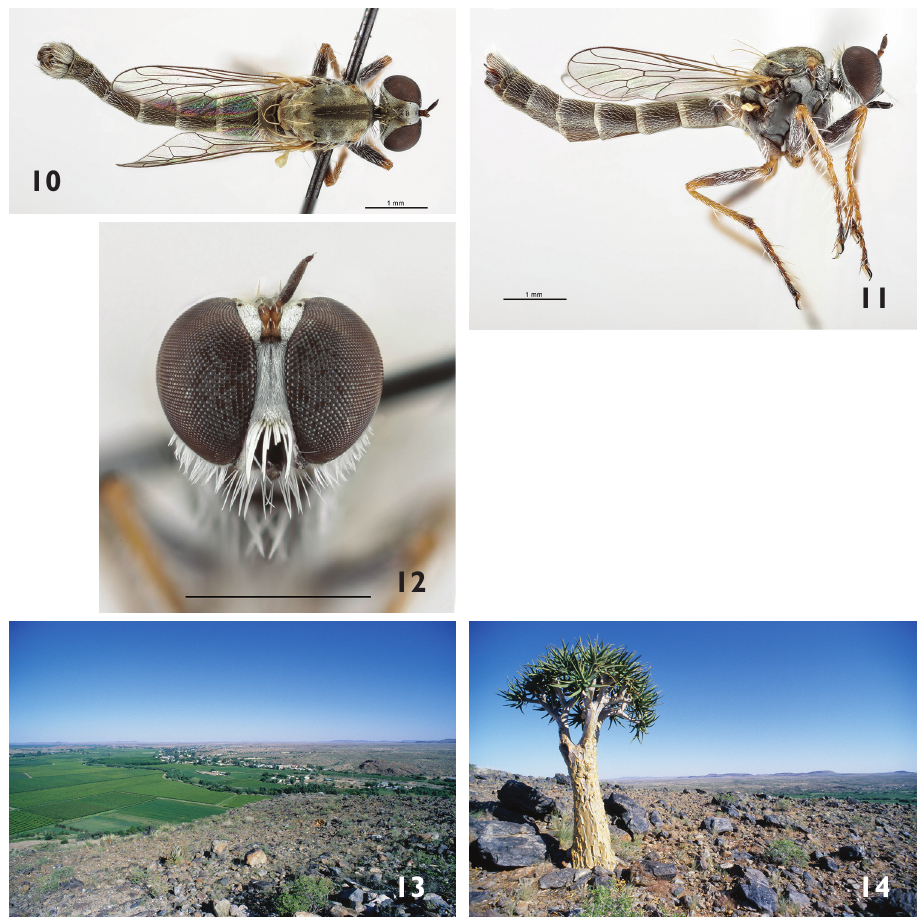
Figures 10–14. Photographs of Trichoura pardeos sp. n. (paratype USNMENT01115152) and habitat: 10 dorsal (Morphbank #860646) 11 lateral (#860648) 12 head anterior (#860650) 13–14 rocky hill habitat at type locality at Tierberg Nature Reserve, Keimoes, Northern Cape, South Africa (28°43'01"S 020°59'48"E). Habitat photographs by T. Dikow. Scale bars: 1 mm.